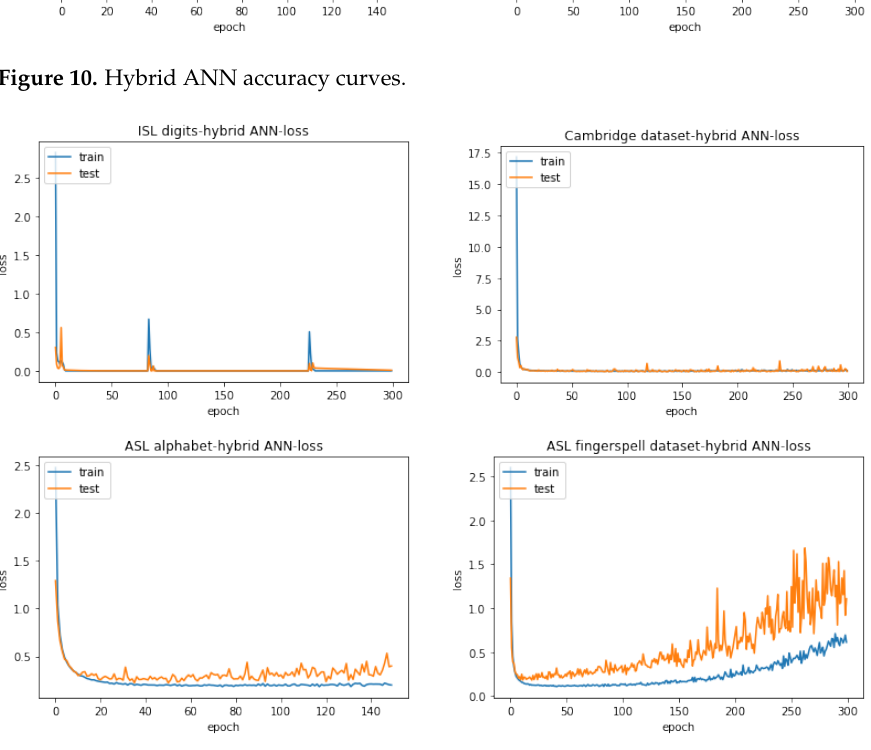
Figure 11. Hybrid ANN loss